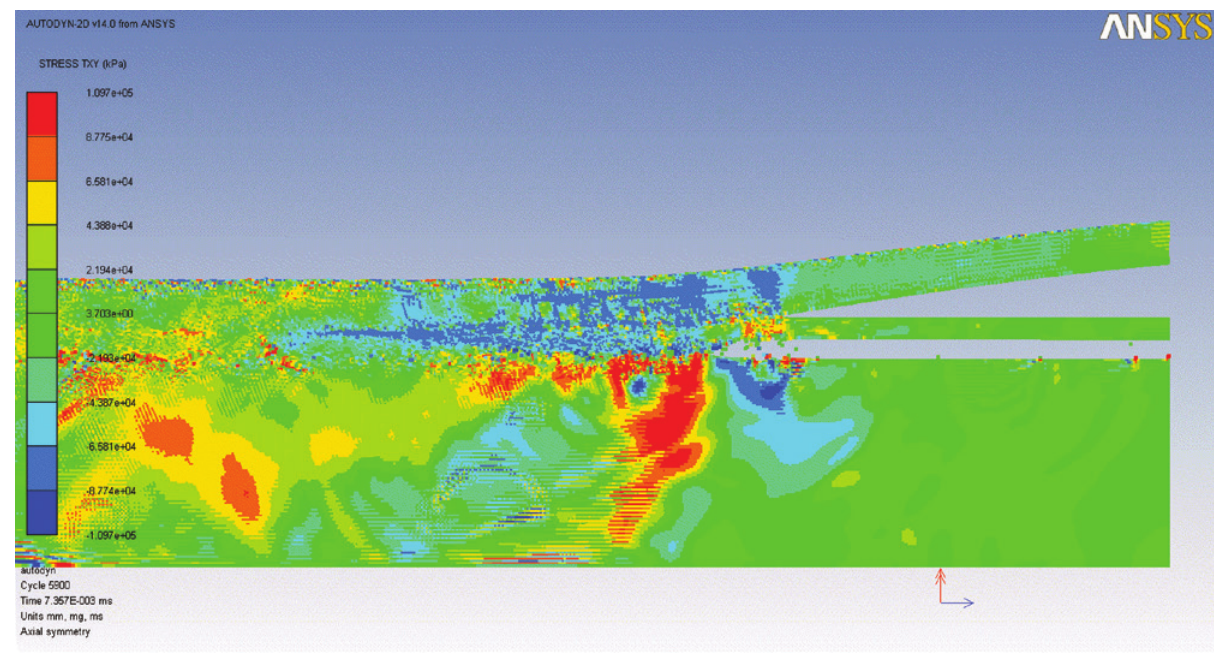
Figure 7: The shear stress distribution of combination in the